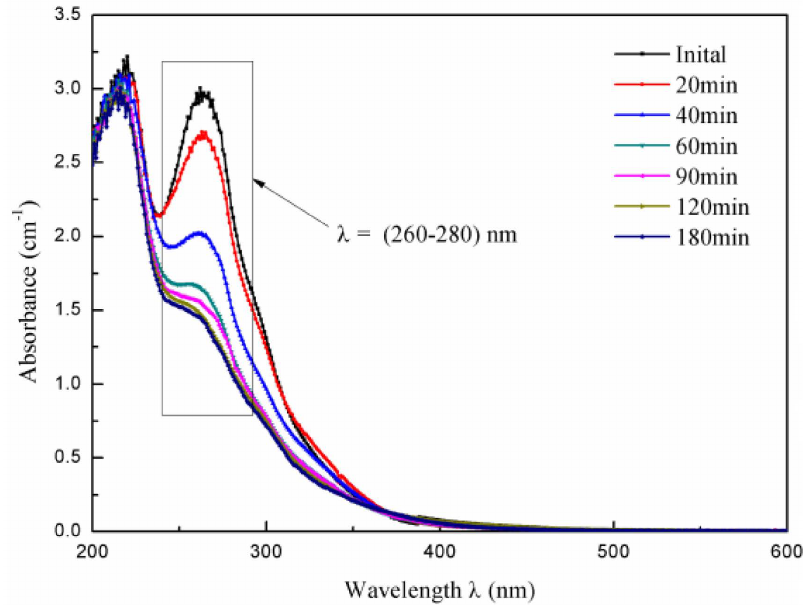
Figure 9. Evolution of UV-vis spectrum in catalytic oxidation of chemical pharmaceutical wastewater.